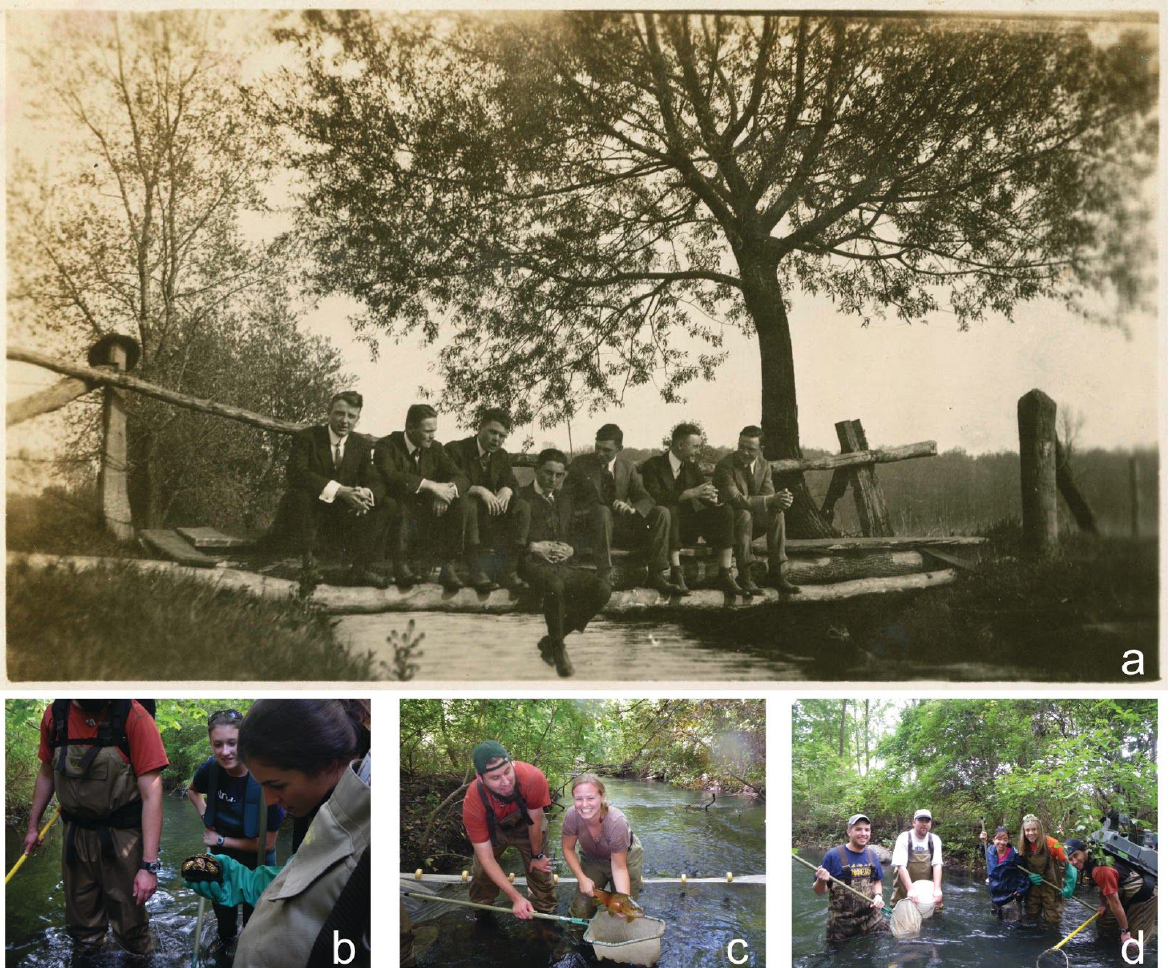
Figure A1.1. Juday Creek has been used to educate students from elementary school to college­age adults as part of curricula where participants learn what organisms live in the stream; this tradition dates to the 1860s at the University of Notre Dame. Top photograph (a) shows the earliest known photograph of Juday Creek near the campus circa 1910, courtesy of the University of Notre Dame Archives. Bottom photographs show (b) undergraduate students (Brianna Kunycky and Kelly Garvy) examining an eastern box turtle a protected species in Indiana (2009); (c) a student (Shayna Sura) holding a non­native brown trout Salmo trutta (2009); and (d) undergraduate and graduate students (from left: Ted ​ ​ Kratschmer, Konrad Kulacki, Sheina Sim, and Megan Schlicte) helping with electrofishing (2008).